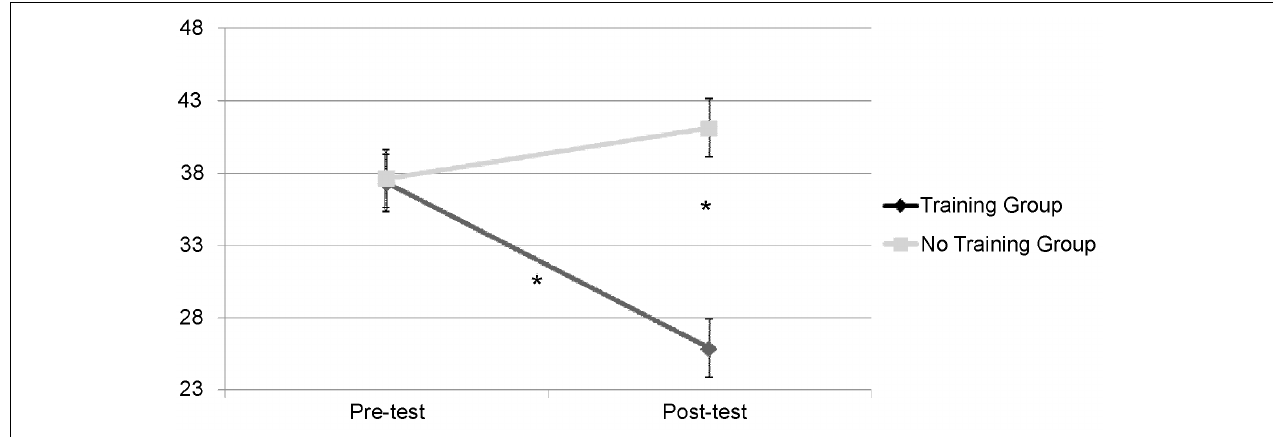
FIGURE 2 | Gambling-related cognitive distortions by Time (pre-test and post-test) and group (Training and No Training). ∗ p < 0.05 .